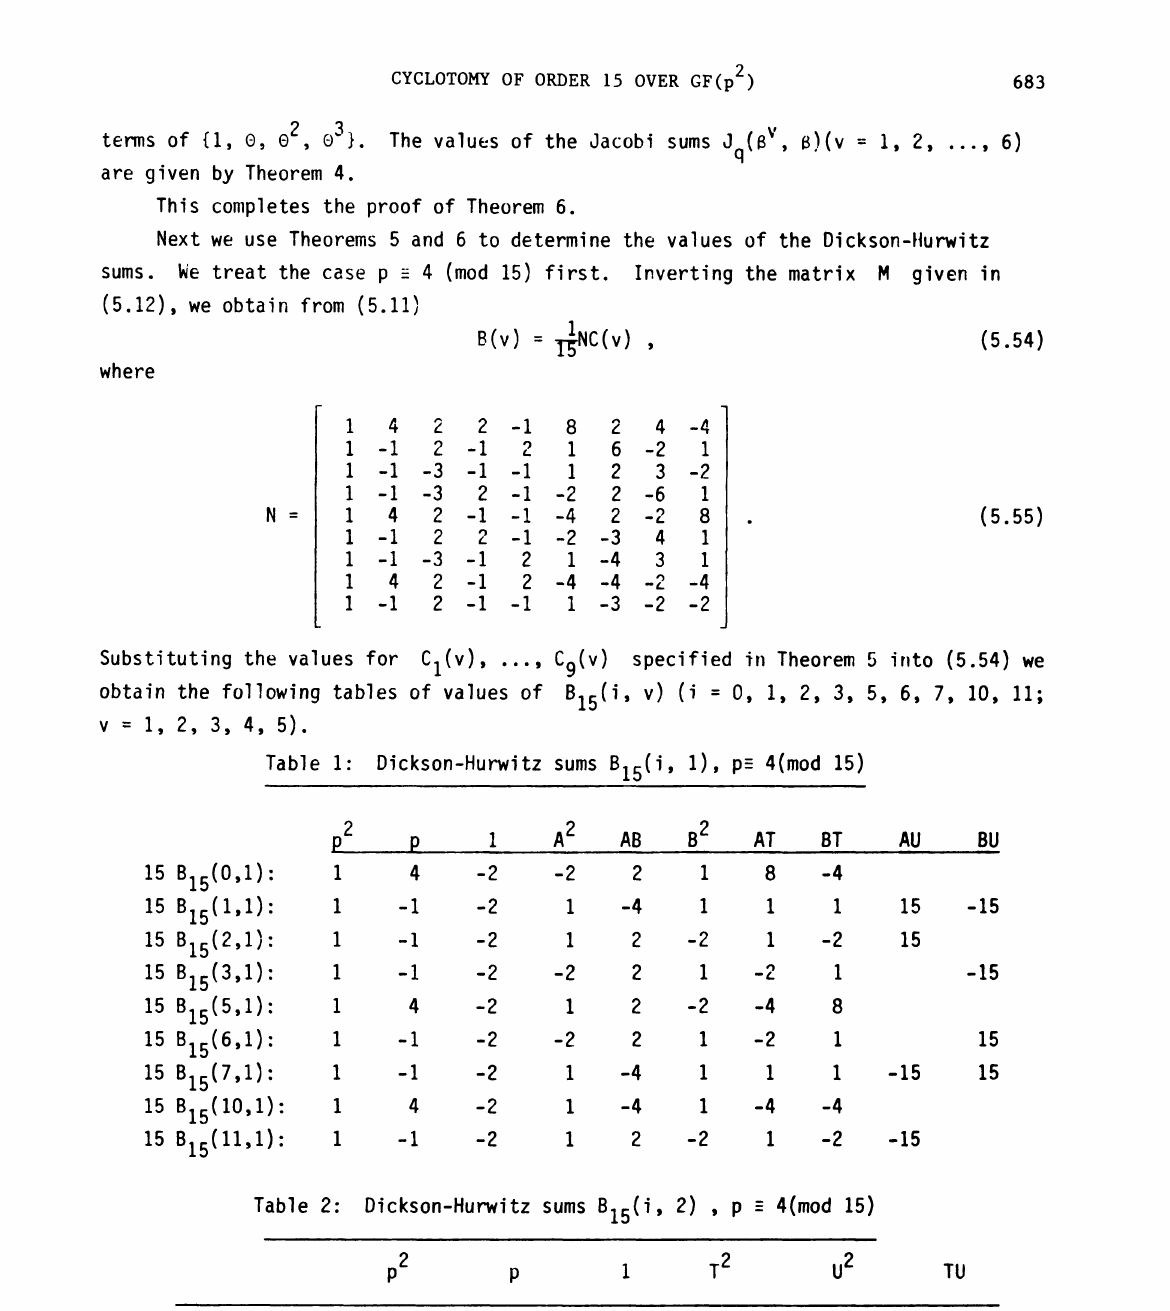
Dickson-Hurwitz sums B15(i,